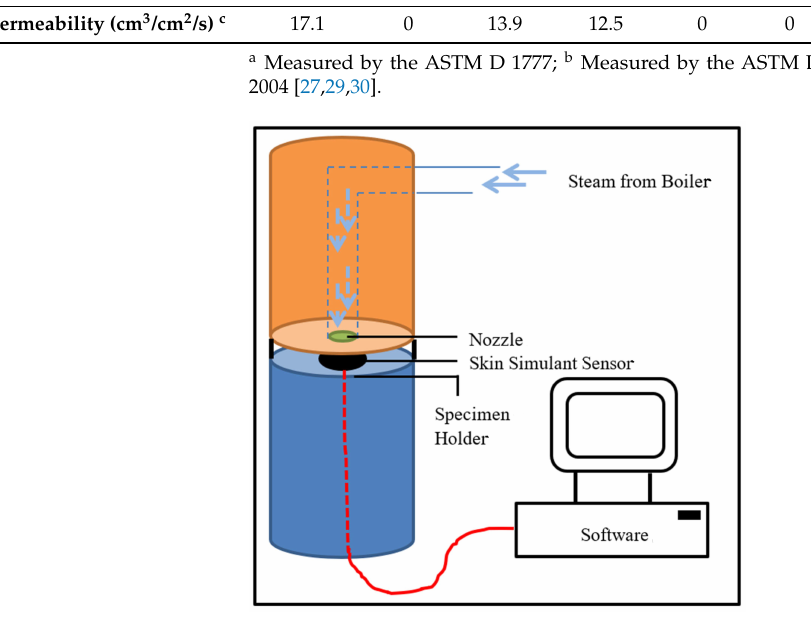
Figure 1. Steam exposure